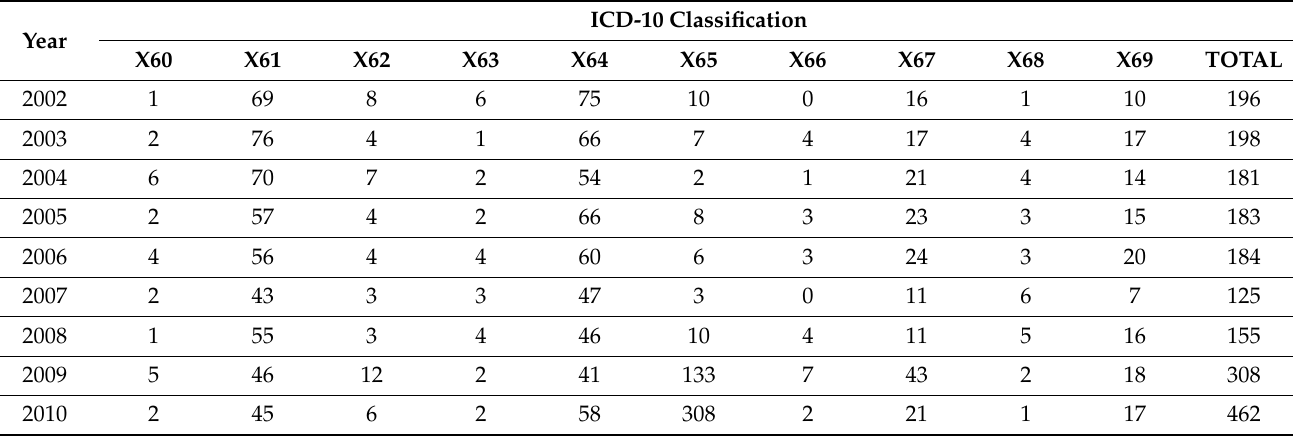
Table 5. Number of deaths in the category: intentional self-harm (suicide) X60–X69 according